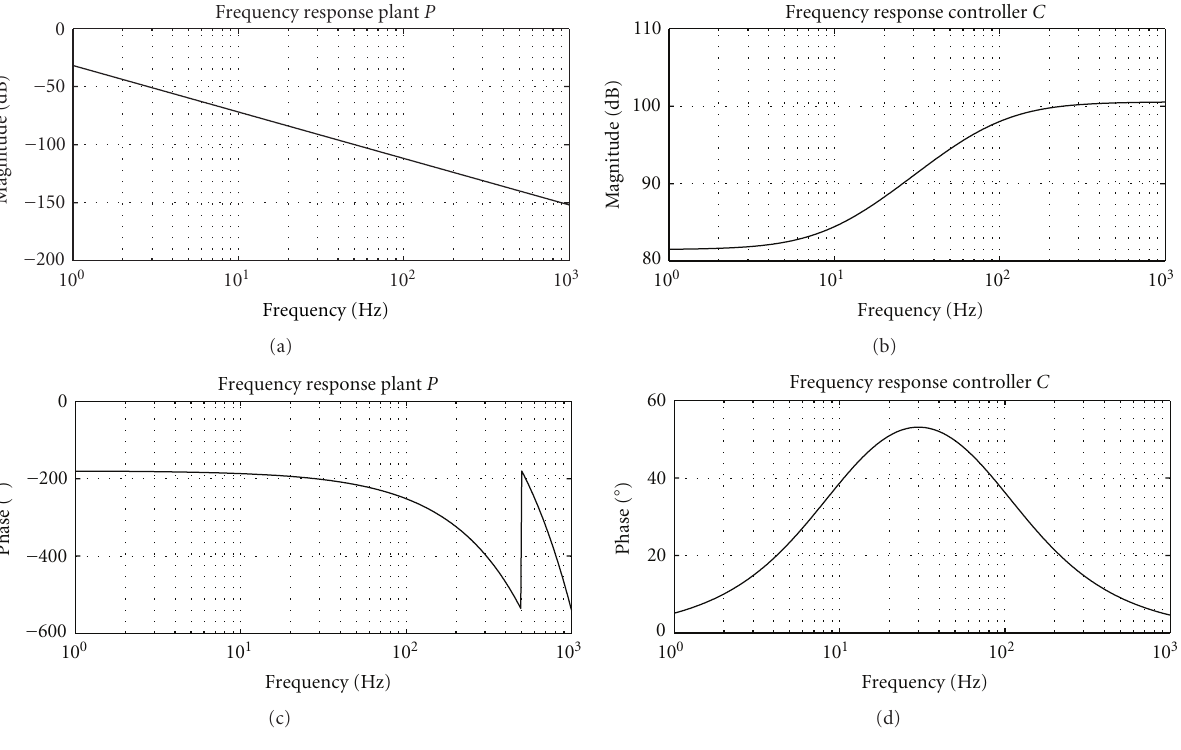
Figure 1: Bode plot of an ideal plant and a controller.